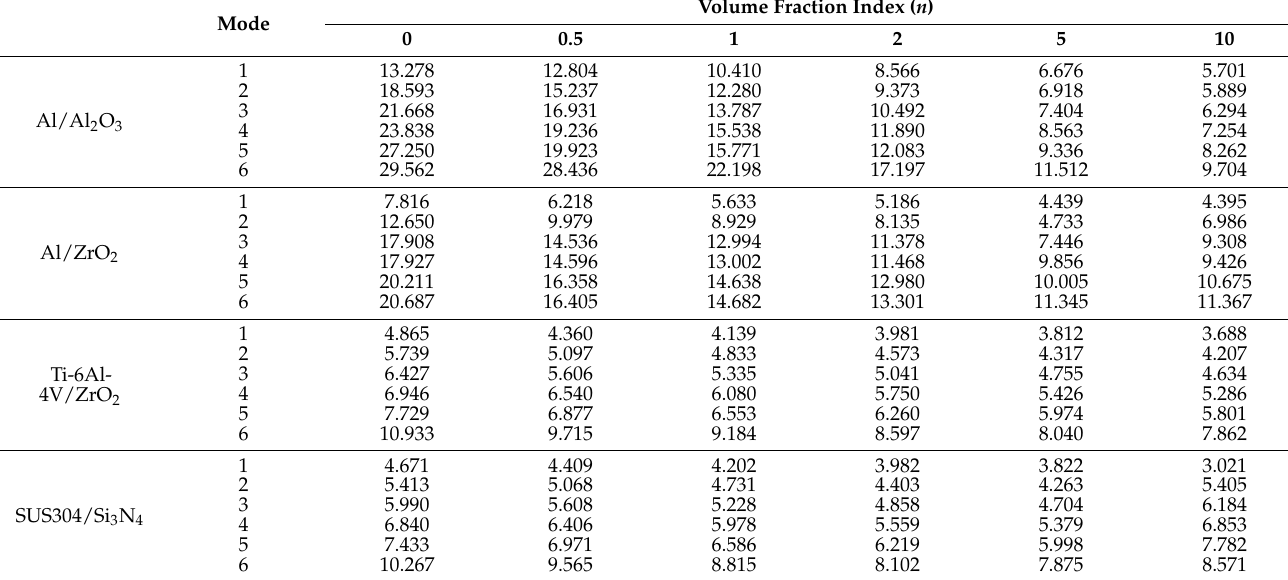
Table 7. Critical buckling load for the 1st six modes for various types of plates under uniaxial load.